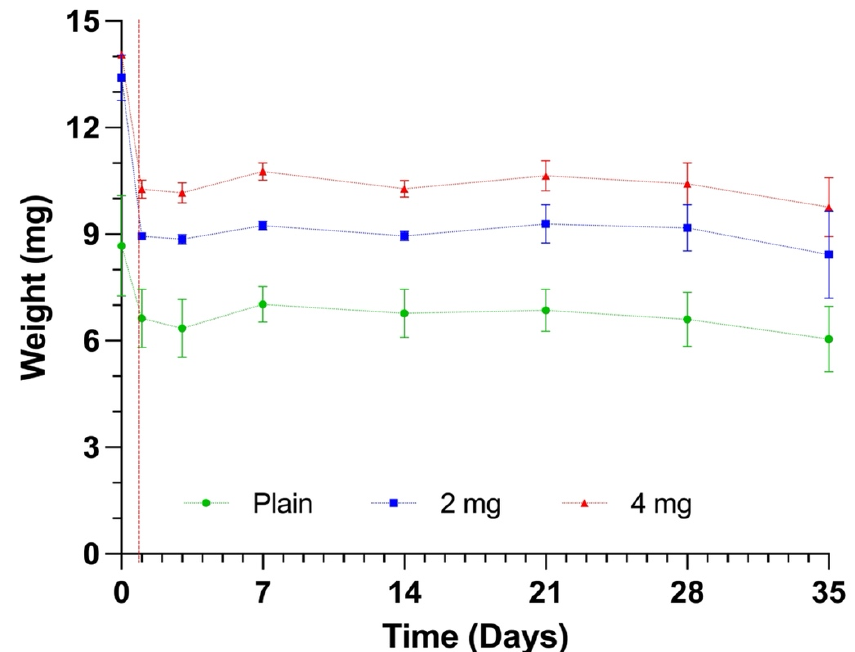
Figure 5. Degradation behaviour of cell-free scaffolds: (green) PLGA scaffolds, (blue) 2 mg nHA/PLGA scaffolds, and (red) 4 mg nHA/PLGA scaffolds. The degradation behaviour is ex- pressed as the mean W D1–35 ± SD. The data are representative of n = 5 scaffolds per type at each time